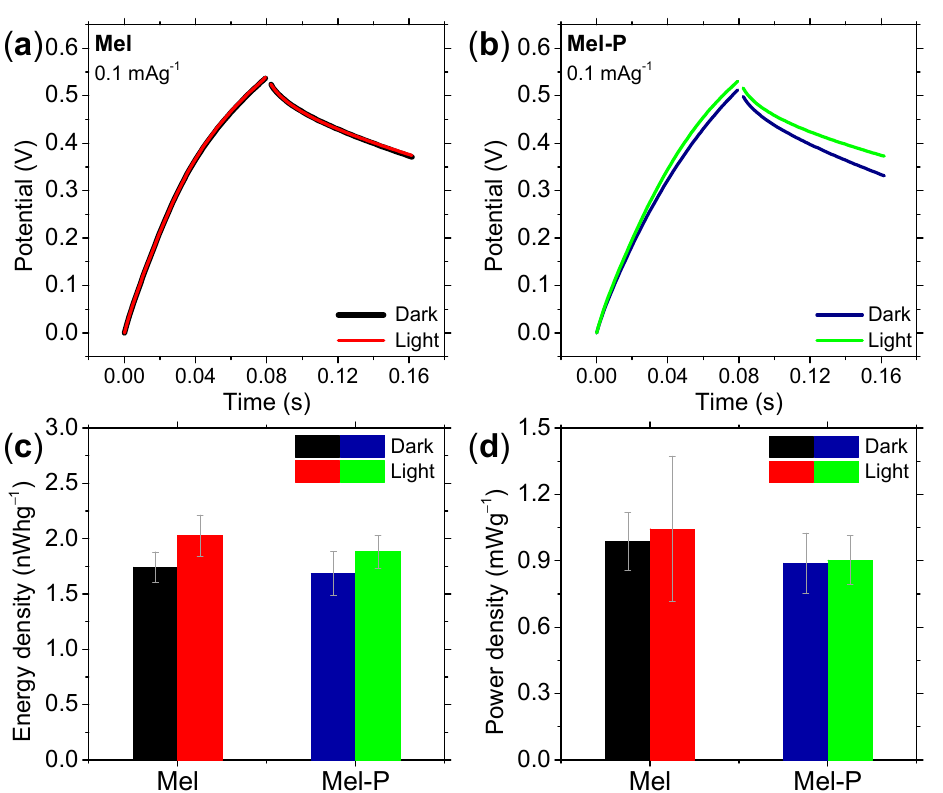
Figure 3. ( a ) Mel and ( b ) Mel-P cyclic voltammogram spectra at different scan rates. ( c , d ) Comparison of the cyclic voltammograms under dark and light conditions at a scan rate of 0.01 Vs − 1 .